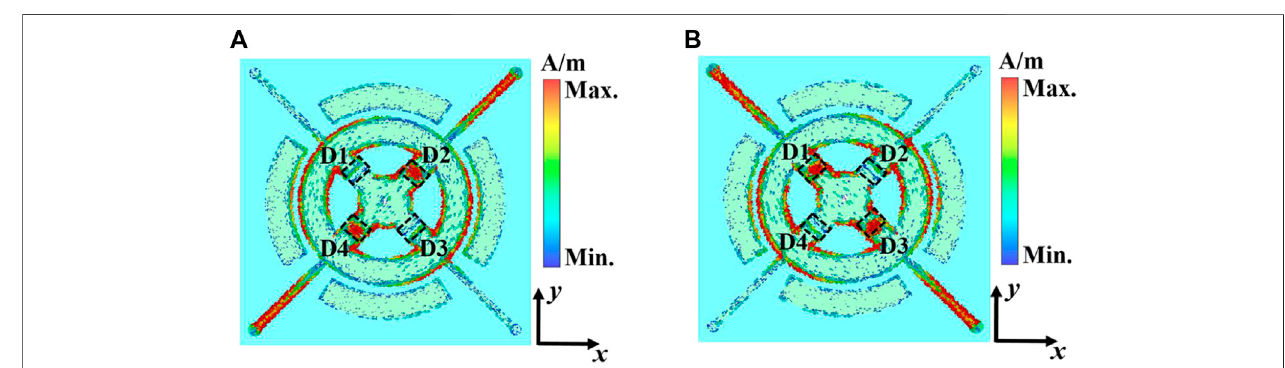
FIGURE 7 | Current distributions at 10.5 GHz (A) when D1 and D3 are on and D2 and D4 are off, and (B) when D1 and D3 are off and D2 and D4 are on.